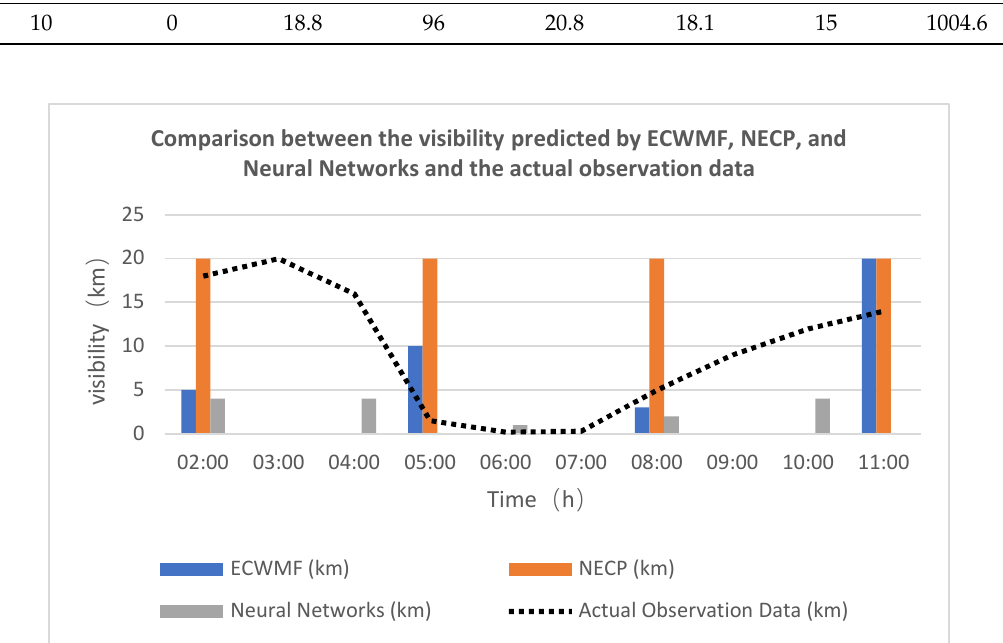
Figure 4. Comparison between the visibility predicted by ECWMF, NECP, and neural networks and the actual observation data.